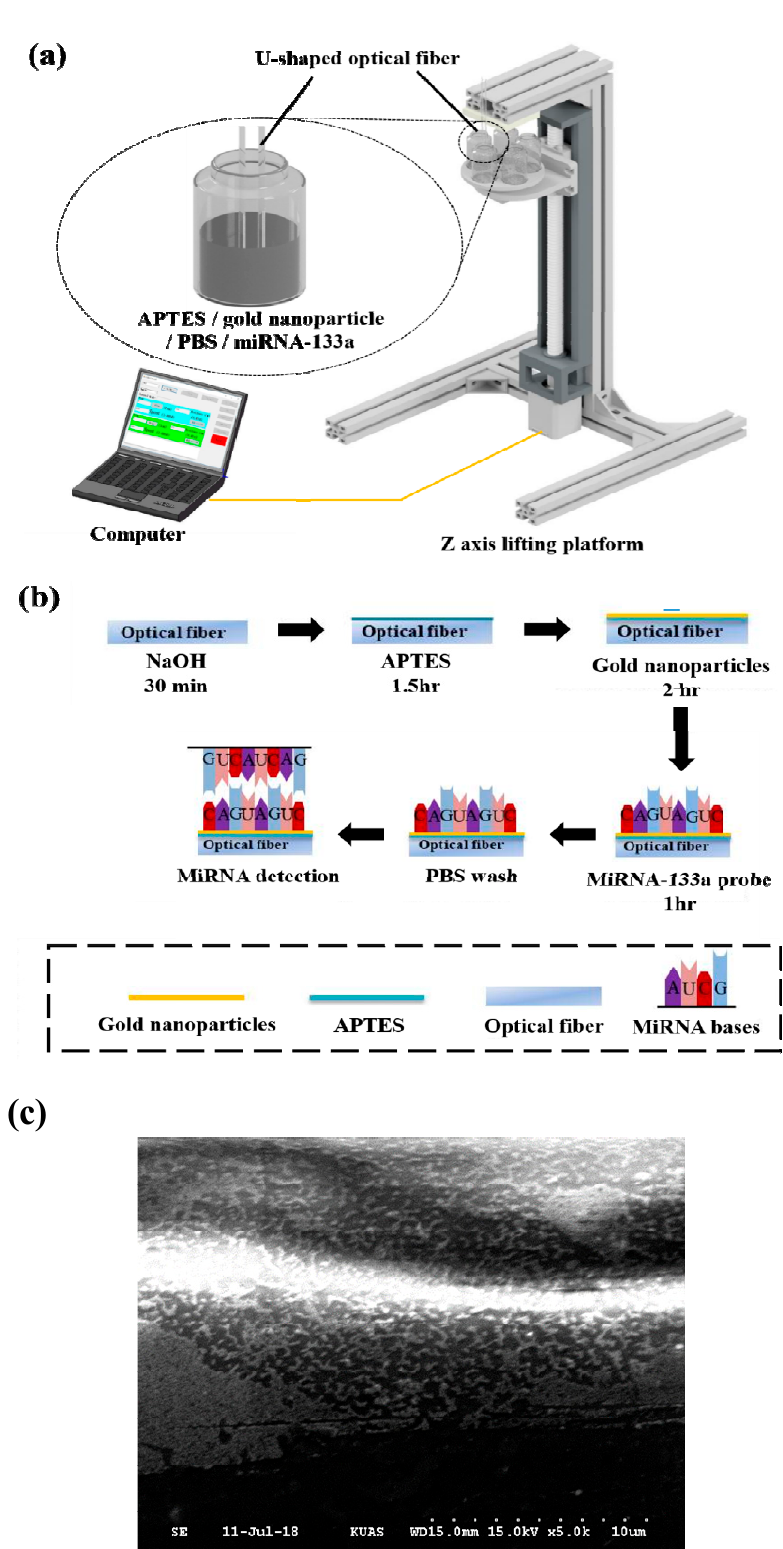
Figure 2. Schematic diagram of miRNA-133a probe coating process. ( a ) Schematic diagram of the experimental setup of miRNA-133a coating; ( b ) procedure of miRNA-133a probe coating; ( c ) SEM image of the optical fiber surface. It clearly shows the fiber surface covered with gold nanoparticles and miRNA-133a.